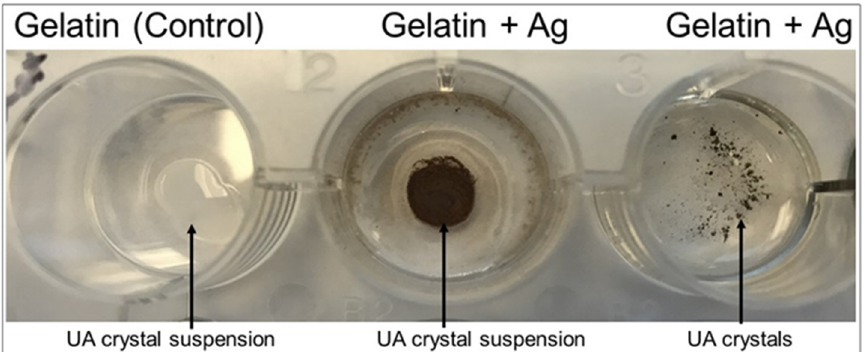
Figure 9. Gelatin matrix testing with urate. Gelatin-silver nitrate beds were developed as previously discussed. Urate crystal suspension and dried urate crystals were individually added to the matrix beds. Both the crystals and crystal suspension induced an effective colorimetric change upon addition to the gelatin-silver nitrate matrix.